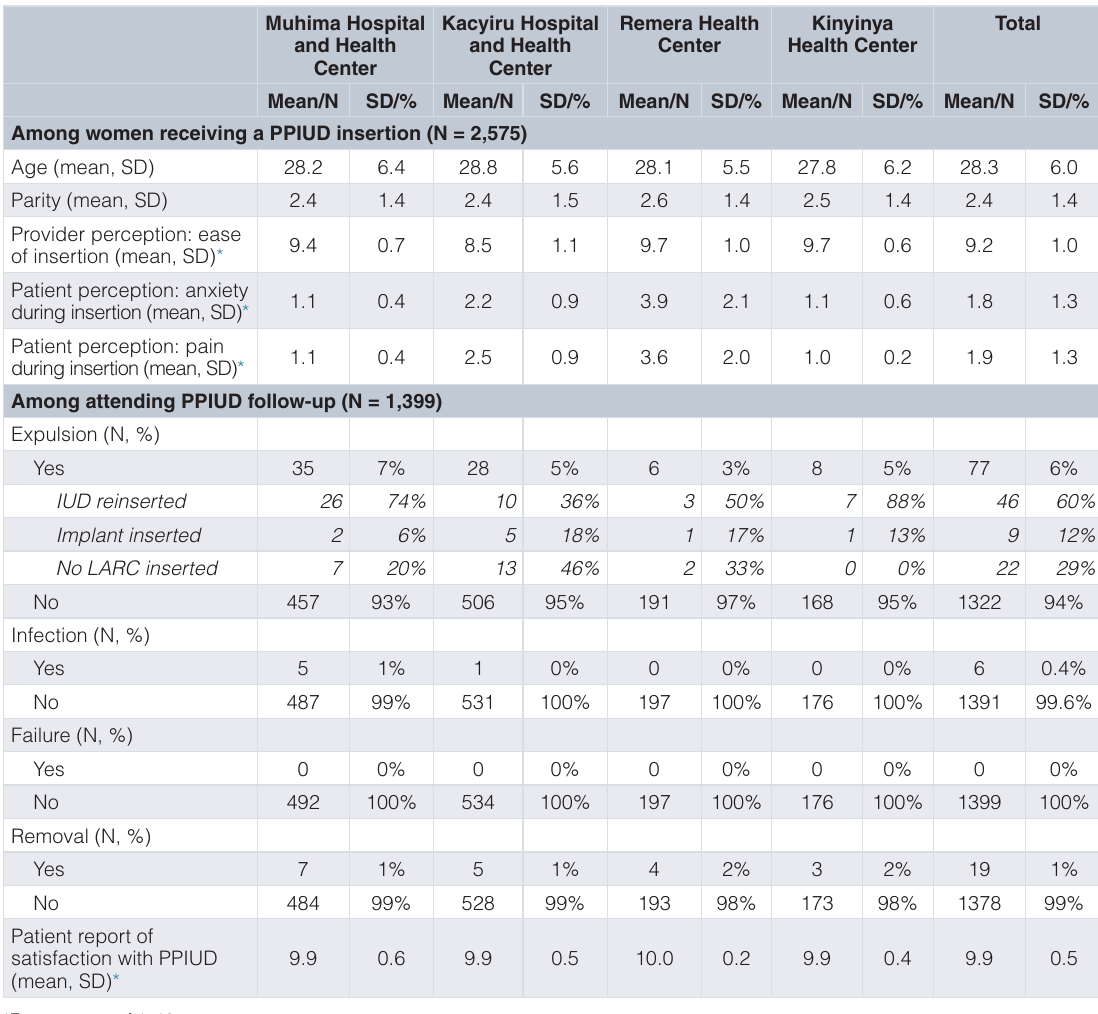
Muhima Hospital Kacyiru Hospital Remera Health Kinyinya Total and Health and Health Center Health Center Center Center Mean/N SD/% Mean/N SD/% Mean/N SD/% Mean/N SD/% Mean/N SD/%